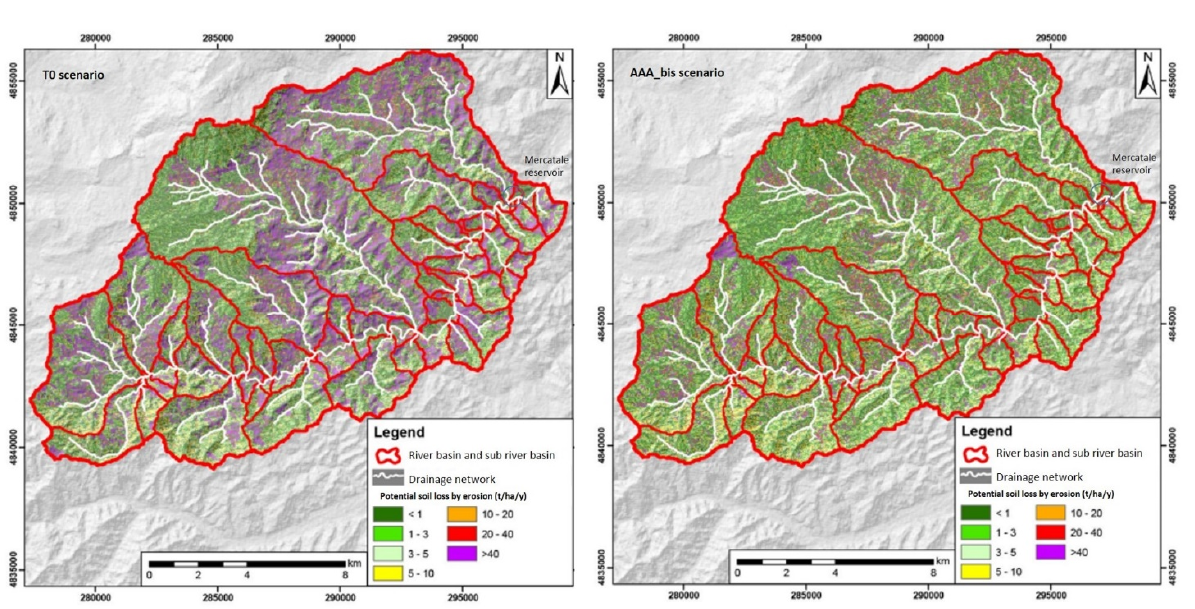
Figure 3. Potential soil loss by erosion in T0 scenario ( left ) and AAA_bis scenario ( right